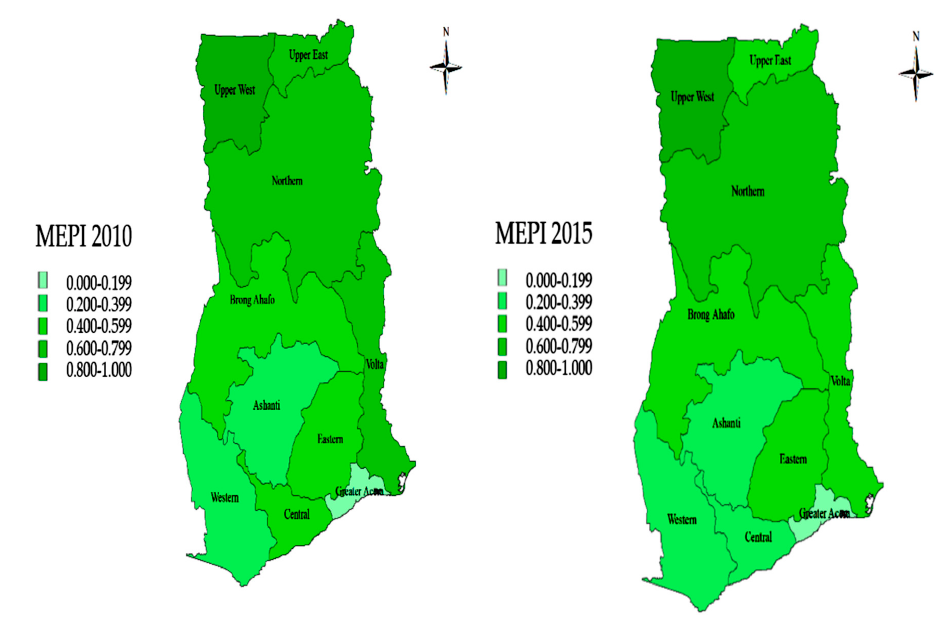
Figure 2. Regional decomposition of MEPI between 2010 and 2015.